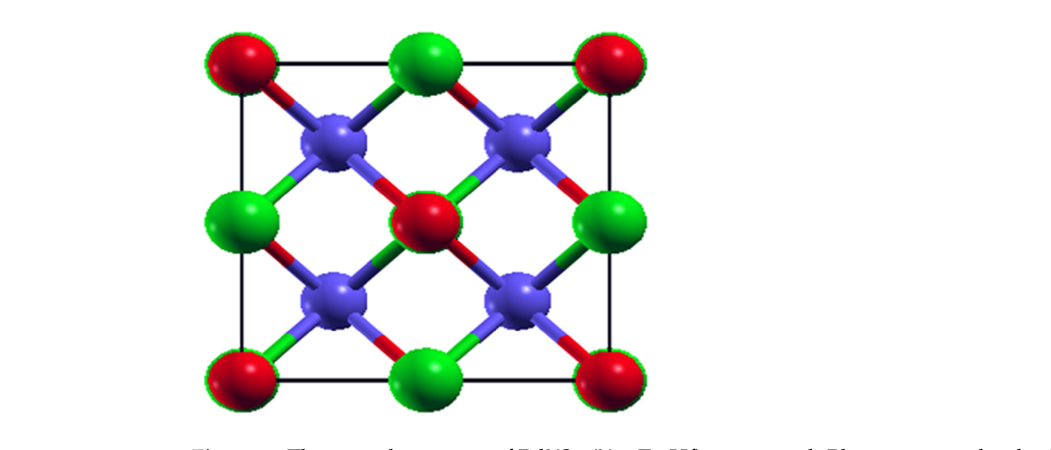
Figure 1. The crystal structure of PdXSn (X = Zr, Hf) compound. Blue, green, and red color represent Pd, X, and Sn atoms, respectively. The position occupied by Pd, X, and Sn are (0.25, 0.25, 0.25); (0.5, 0.5, 0.5); and (0, 0, 0), respectively. Table 2. Optimized lattice parameters of PdXSn (X = Zr, Hf) compound. Parameter Lattice Constant ( Ǻ ) Band Gap (eV)